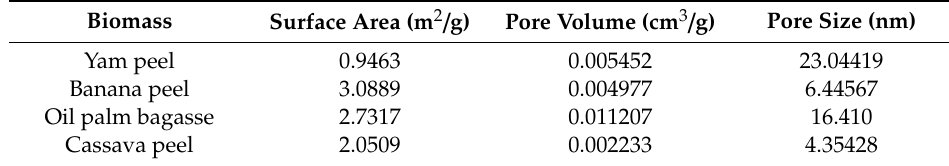
Table 4. Surface area and porosity analysis of